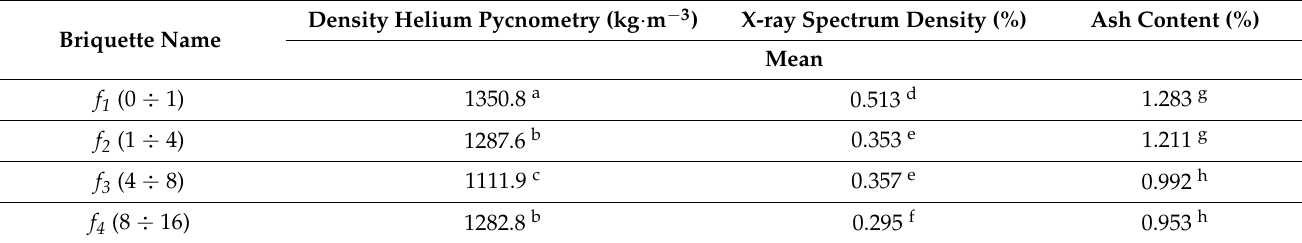
Table 4. Characteristics of the measured parameters to the type of